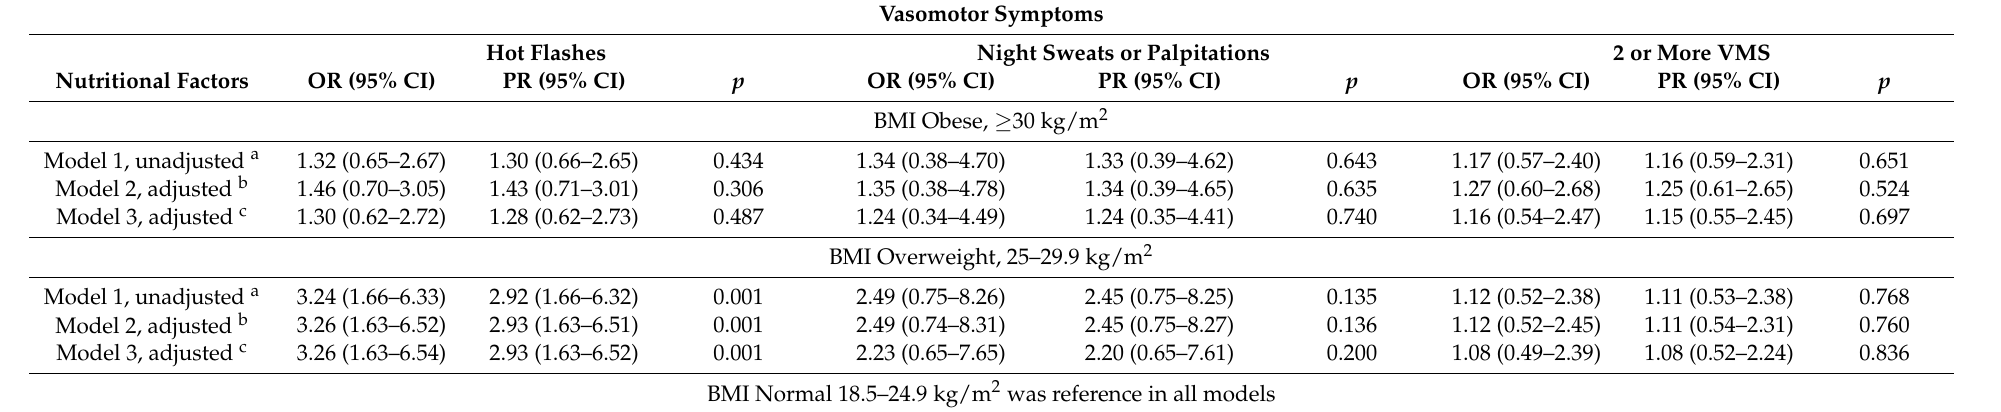
Table 2. Association between nutritional risk factors and vasomotor symptoms in women aged 40–65 years ( n = 406). Vasomotor Symptoms Hot Flashes Night Sweats or Palpitations 2 or More